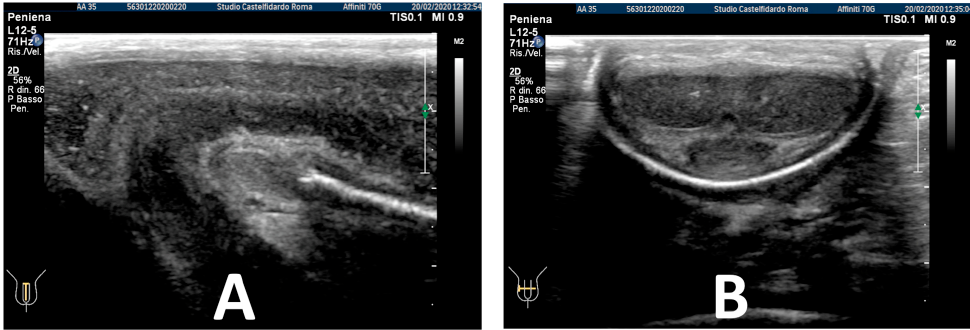
Figure 8. Ultrasonography of the penis after the 3rd therapy cycle. ( A ) Longitudinal view; ( B ) axial view. The multimodal therapy with antioxidants was suspended. No side effects were reported by the patient after treatment. The same physician performed all the ultrasonography examinations.